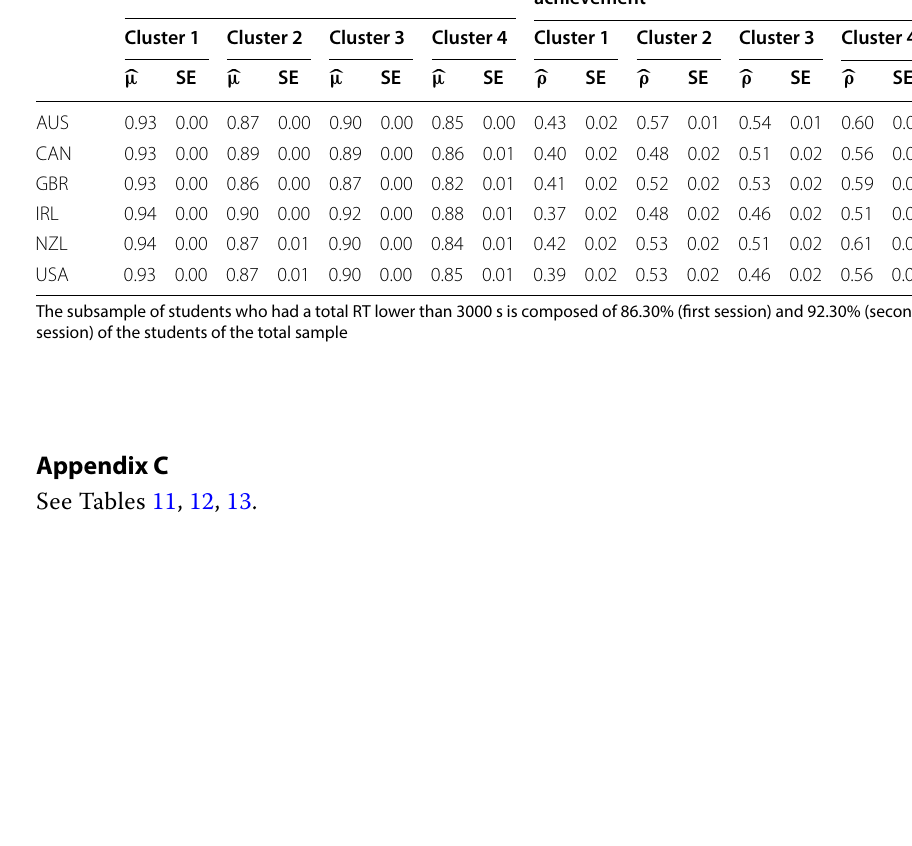
Table 10 Mean student test-taking effort and correlation with science achievement computed on the subsample of students whose total RT for the session is lower than 3000 s (50 min) Country Mean effort Correlation between effort and science